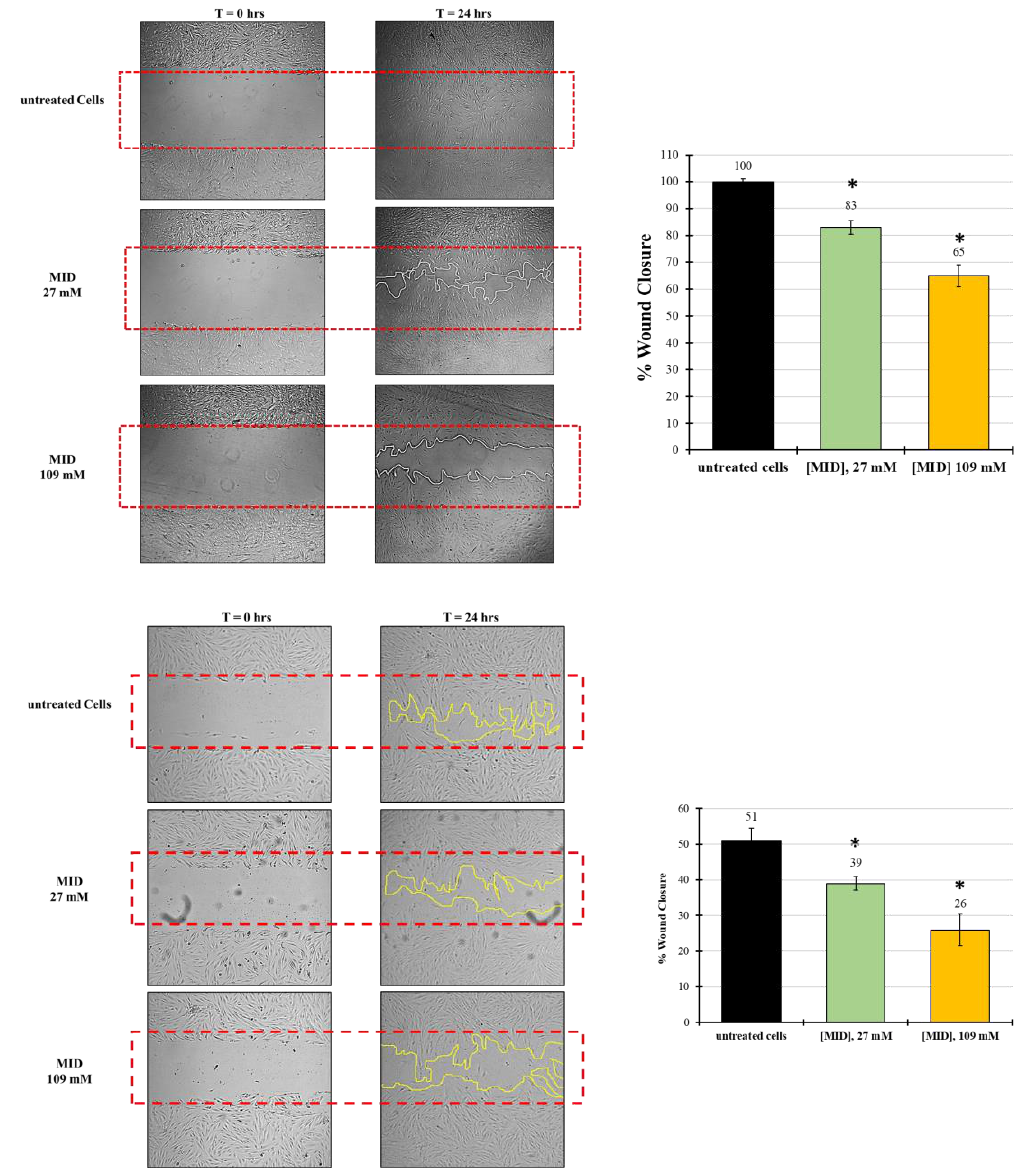
Figure 5. The effect of MID on ( A ) HTMC or ( B ) HSF cell migration was evaluated by the scratch wound assay. Cells were treated with MID at selected concentrations; images were taken at time 0 and 24 h after the artificial wound was made. The red dotted box represents the size of the original wound. The wound area was measured by Image J software. The percentage of migration was calculated as the ratio of the average area reduction at the time of analysis to time 0. Data represent the mean of triplicated experiments ± standard deviation. Scale bar: 100 μm. * p < 0.05 significative differences with respect to control wells (ANOVA).